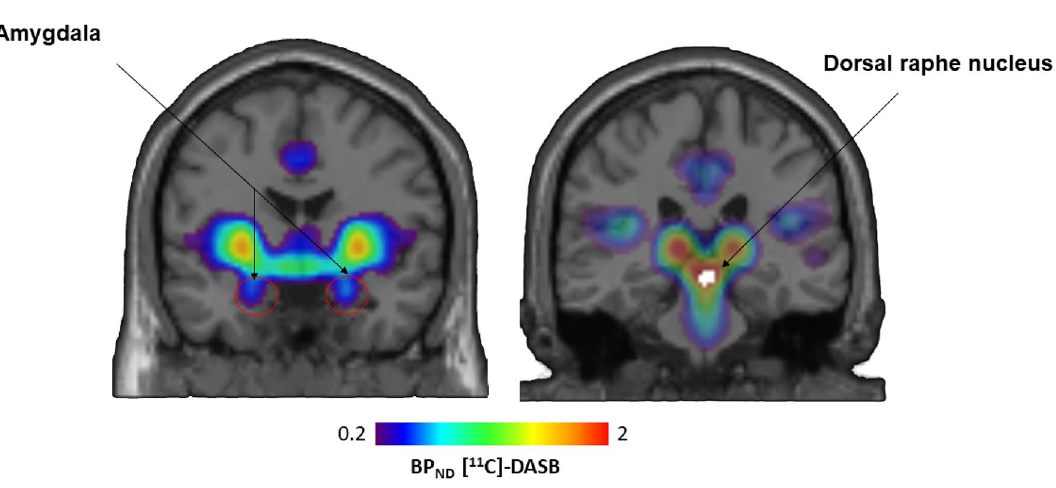
Figure 1. Statistical map of the BP ND [ 11 C]DASB showing SERT availability. The dorsal raphe nucleus (DRN) ROI used to assess SERT availability is shown in